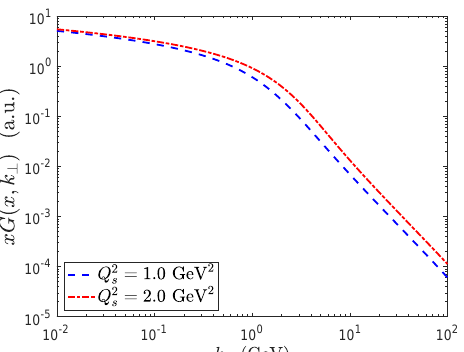
Figure 8. WW gluon TMD distribution as a function of k scale. A transition between saturation and perturbative regime is observed near k dependence of the distribution is effectively accounted by the saturation scale. In a more careful treatment, the functional shape of the distribution also depends on x .